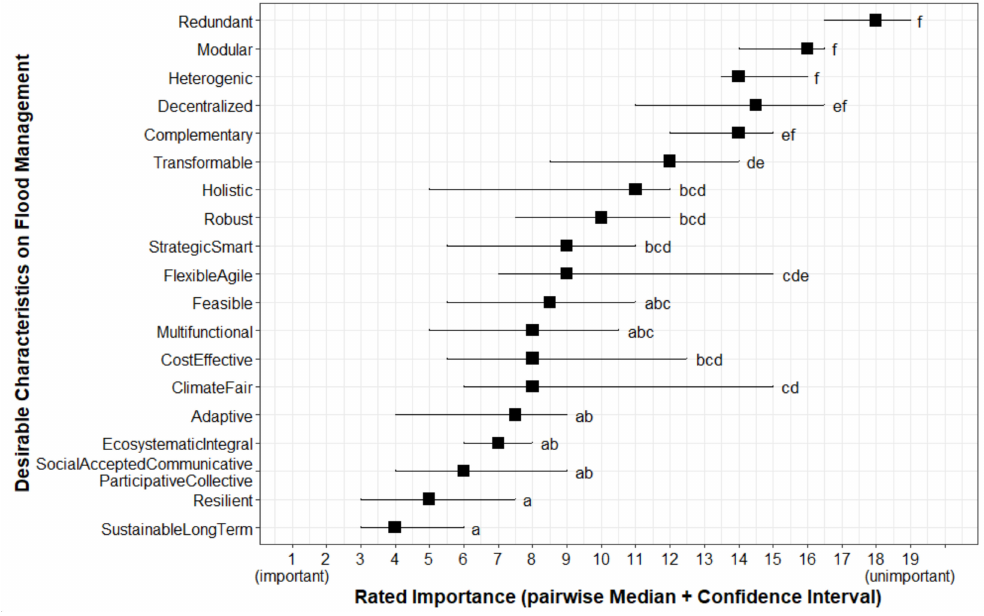
Figure 10. Statistical differentiation by the Friedman–Conover test of characteristics attributed to FM regarding their importance (Friedman χ fm and Kendall Wt test-statistics: p < 2.2 × 10 − 16 , df = 18, χ fm = 156.74, Wt = 0.311). Ratings of characteristics sharing a letter (e.g., “a” in Resilient and Feasible) could not be statistically